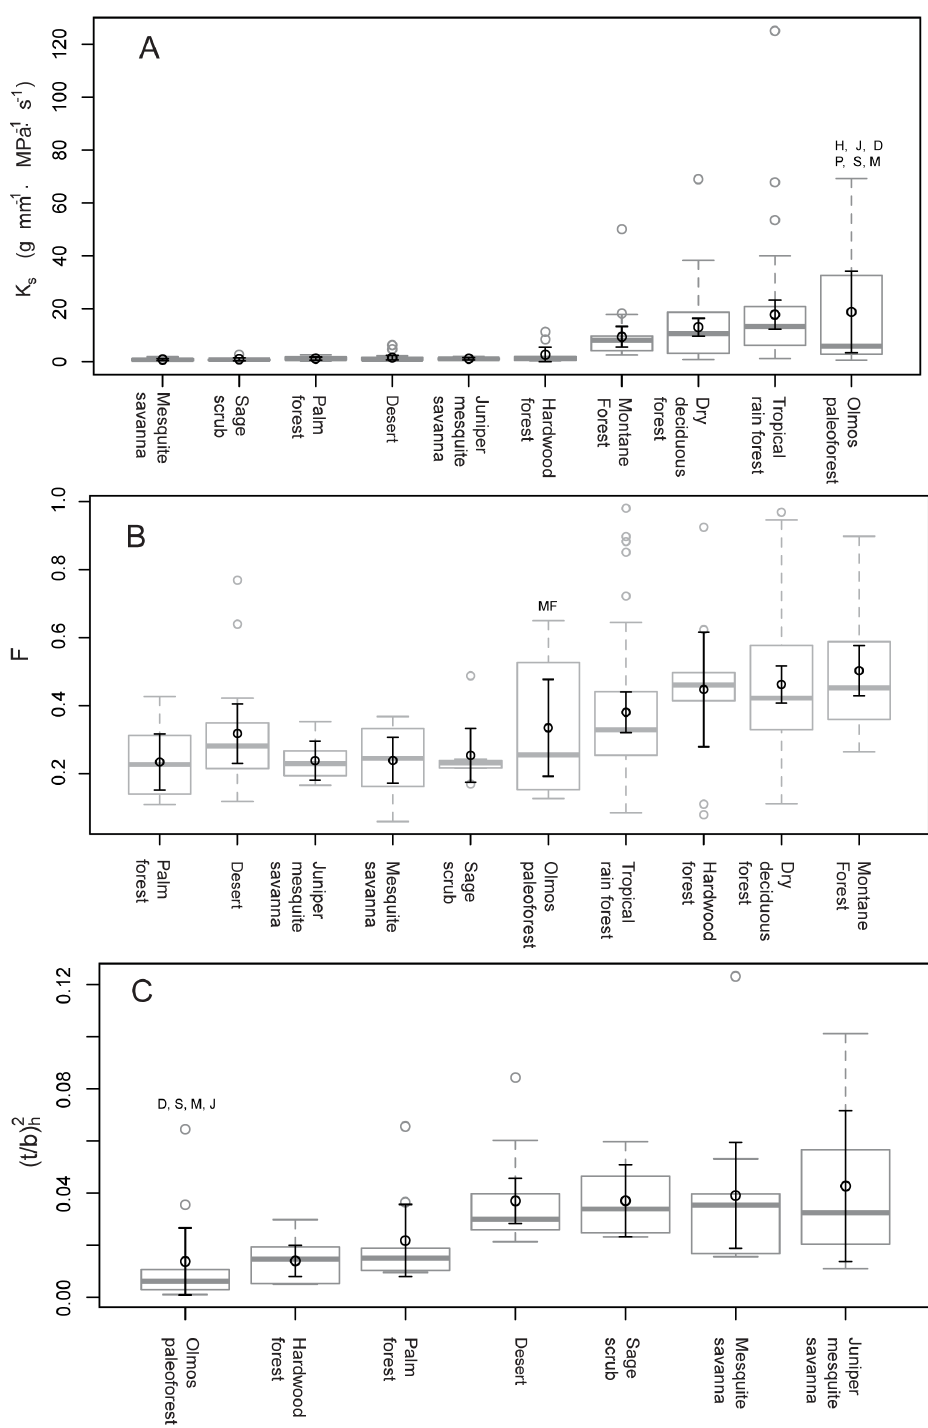
Figure 2. Comparison of a) potential conductivity, b) vessel fraction and c) implosion resistance between the Olmos Formation fossil woods and extant communities. Box plots in grey show the median and interquartile distance of each one of the variables. The black circle and error bars represent the mean and 6 95% confidence intervals. Box plots showing implosion resistance only includes the drier extant communities and the Olmos formation flora. Sample sizes: mesquite savanna (M)=11, sage scrub (S)=8, palm forest (P)=9, desert (D)=17, juniper- mesquite savanna (J)=7, hardwood forest (H)=10, montane forest (MF)=25, dry deciduous forest=56, tropical rain forest =54, Olmos flora=10. The two different desert communities were pooled for this analysis. Significant difference between the Olmos pleoflora and extant vegetation types were determined using Mann-Whitney test for potential conductivity, and ANOVA for F and implosion resistance.